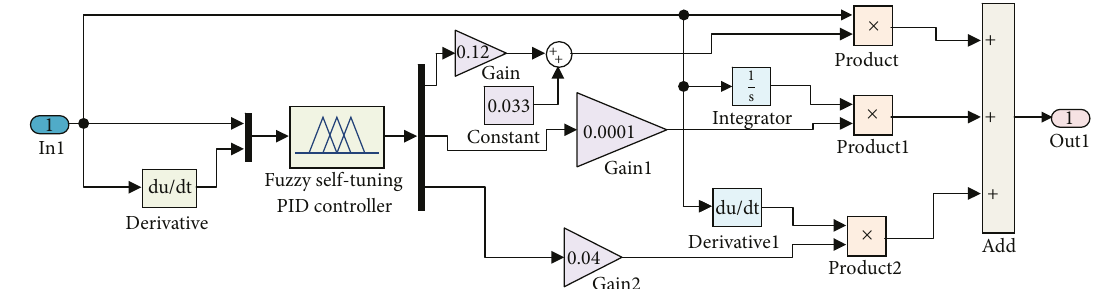
Figure 9: Fuzzy self-tuning PID simulation in